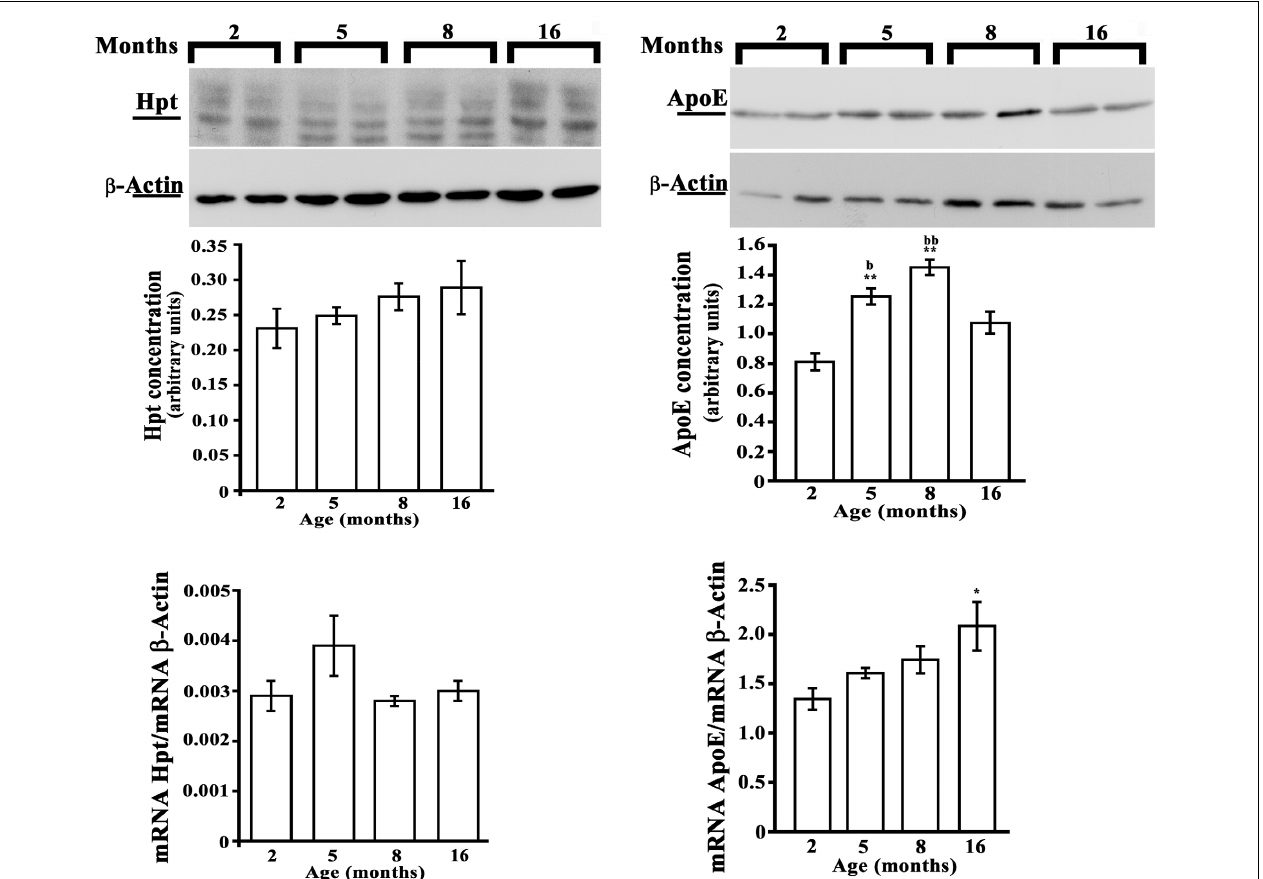
FIGURE 7 | Hpt and ApoE expression in rat cerebral cortex. Hpt (left side) and ApoE (right side) protein and mRNA levels in cortex of 2, 5, 8, and 16 month-old rats are shown. Representative Western blots stained with anti-Hpt (left) or anti-ApoE (right) IgG, and anti-actin IgG are shown. Samples were analyzed by 12.5% SDS-PAGE and western blotting. Immunocomplexes were detected by rabbit anti-Hpt and GAR-HRP IgGs (on the left) or by goat anti-ApoE and RAG-HRP IgGs (on the right). After Hpt or ApoE detection, the